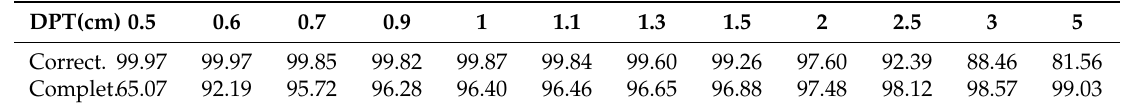
Table 3 . Completeness and correctness percentage for different values of the Douglas Peucker tolerance (DPT).